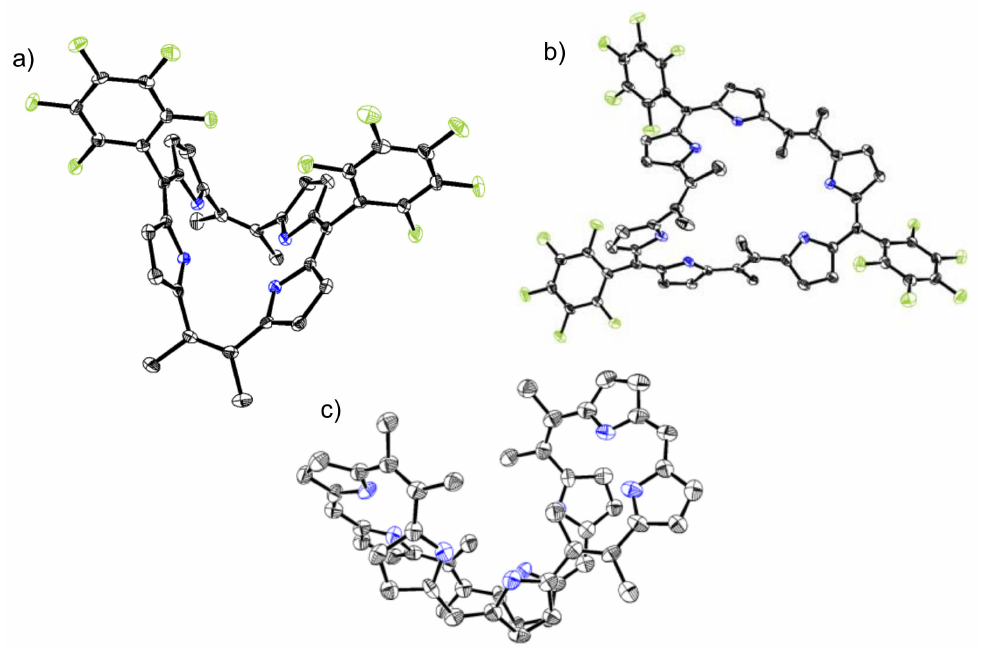
Figure 2. Crystal structures of ( a ) Me-Por, ( b ) Me-Hex, and ( c ) Me-Oct. Hydrogen atoms of three compounds and pentafluorophenyl groups of ( c ) were omitted for clarity. Thermal ellipsoids represent 50% probability.